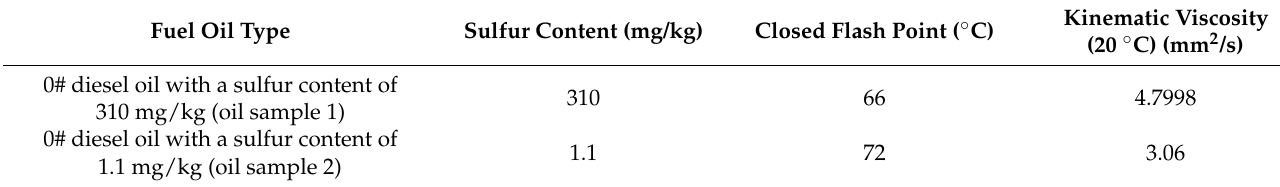
Table 1. Physical and chemical properties of 0# diesel oil.